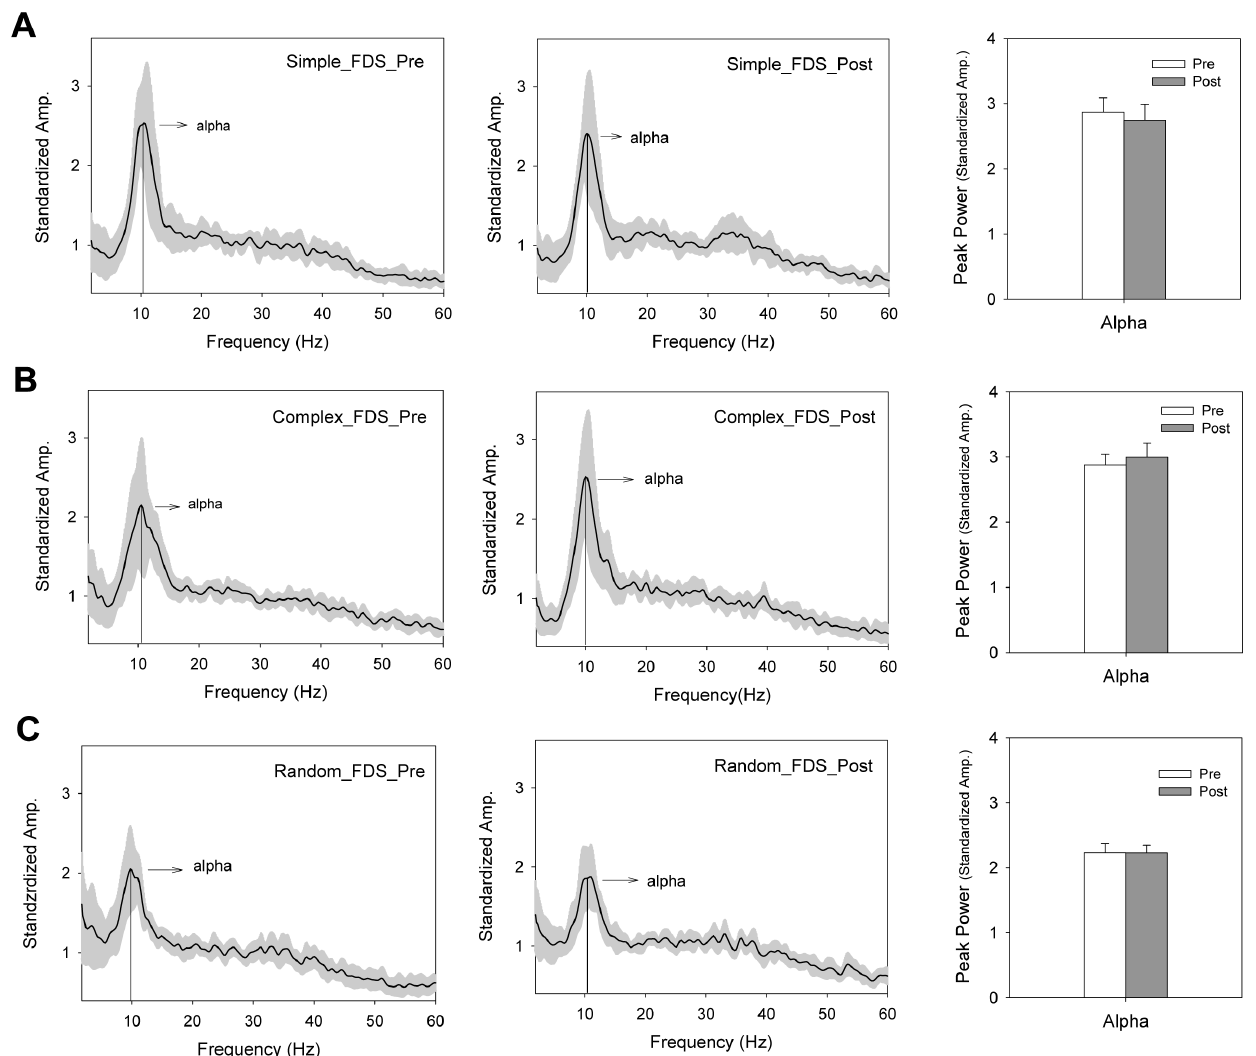
Figure 7. Pooled power spectra of rectified EMGs from the FDS muscle before and after practice. (A) Simple protocol, (B) Complex protocol, and (C) Random protocol. There was a prominent 8–12 Hz oscillation peak in the pre-test and post-test sessions. The shaded area represents the standard deviation of the pooled spectral profile. (FDS: the flexor digitorum superficialis).